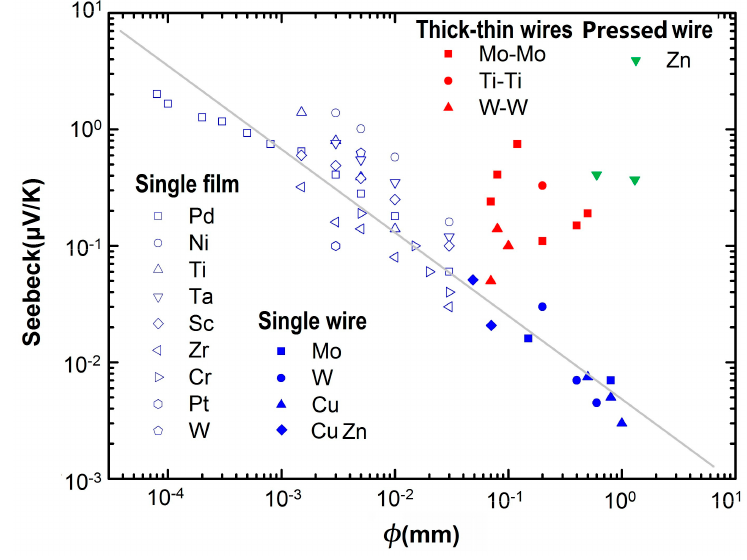
Figure 9. An overall view of the experimental data of a variety metallic samples. Those obtained from a single piece of thin film are plotted in hollow blue symbols. Those obtained from a single piece of thick wire are plotted in solid blue symbols. The data obtained from thick-wire, thin-wire dual-arm samples are plotted in solid red symbols. Data for the pressed Zn wire are plotted in solid green symbols. φ is a nominal dimension.